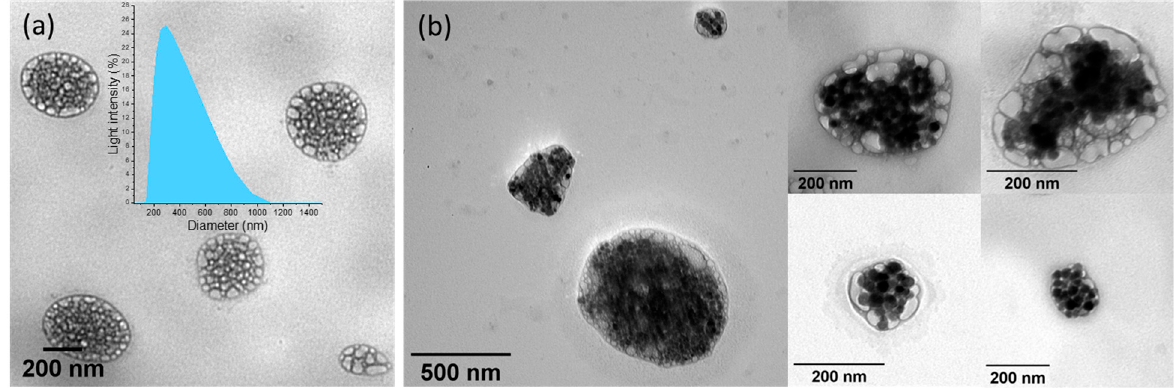
Figure 2. TEM images of ( a ) TsLs and ( b ) TsMLs. The inset represents the DLS spectrum of